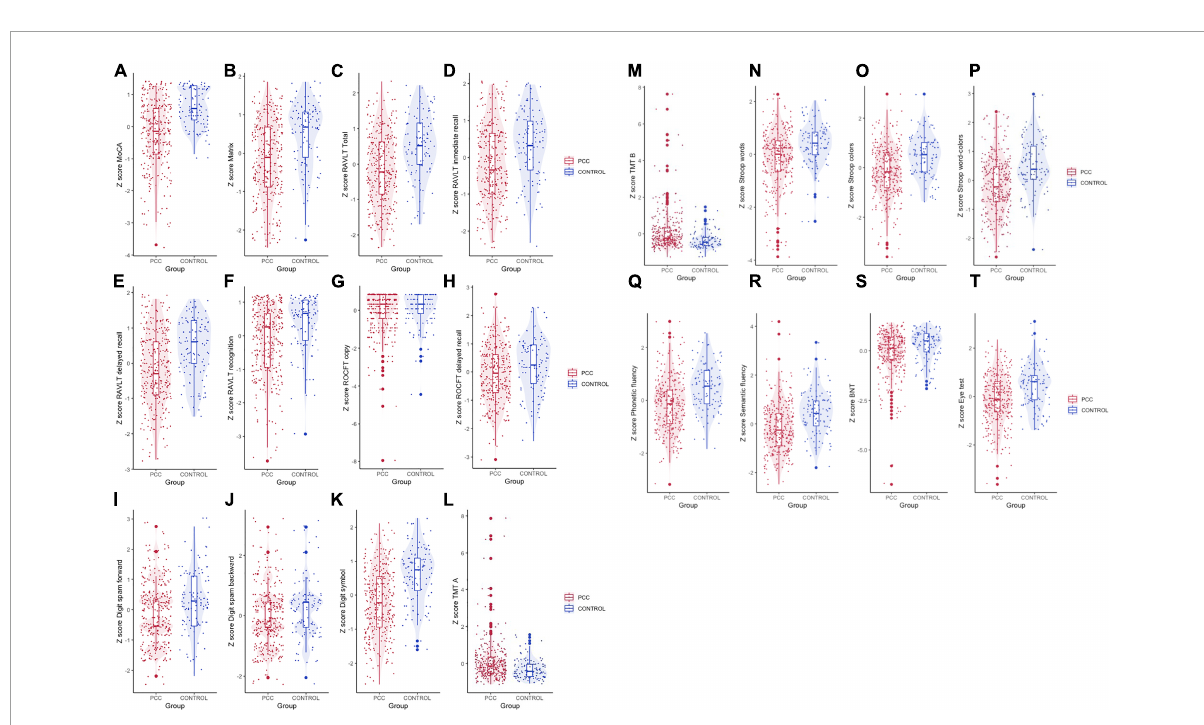
FIGURE2 Violin plot for cognitive variables of PCC and HC groups. Data are presented as Z -scores. (A) MoCA, (B) matrix reasoning, (C) Rey’s Auditory Verbal Learning test (RAVLT) total (sum of 5 trials), (D) RAVLT immediate recall, (E) RAVLT delayed recall, (F) RAVLT recognition, (G) Rey–Osterrieth Complex Figure Test (ROCFT) copy, (H) ROCFT delayed recall, (I) digit spam forward, (J) digit spam backward, (K) digit symbol test (coding), (L) Trail Making Test (TMT) A, (M) TMT B; (N) Stroop test words, (O) Stroop test colors, (P) Stroop test word-colors (interference), (Q) phonetic fluency (PMR), (R) semantic fluency (animals), (S) Boston Naming Test (BNT), and (T) Reading the Mind in the Eyes test (Eye